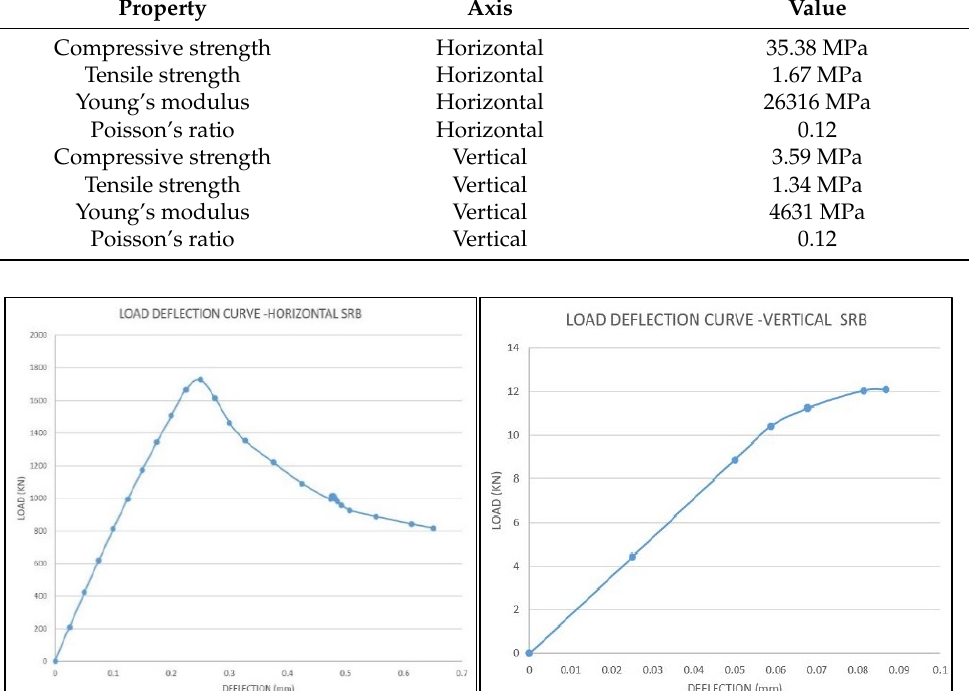
Table 15. The material properties of the SRMB.